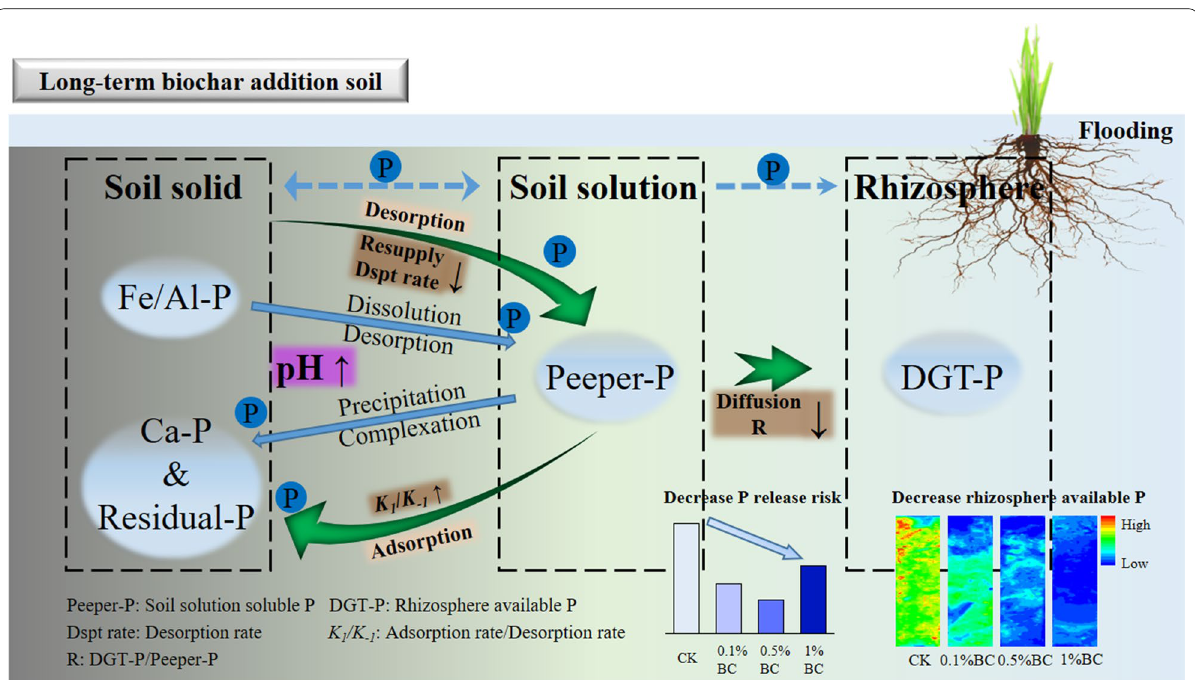
Fig. 6 Conceptual diagram of the decreased P availability and release risk induced by biochar long-term application (9-years). Fe/Al-P, Ca-P and Residual-P represent soil solid phase P. Peeper-P represents soil solution soluble P, DGT-P represents rice rhizosphere available P. Dspt rate represents the desorption rate of P from soil solid to solution. K 1 /K -1 is the ratio of adsorption rate to desorption rate. R is the ratio of DGT-P to